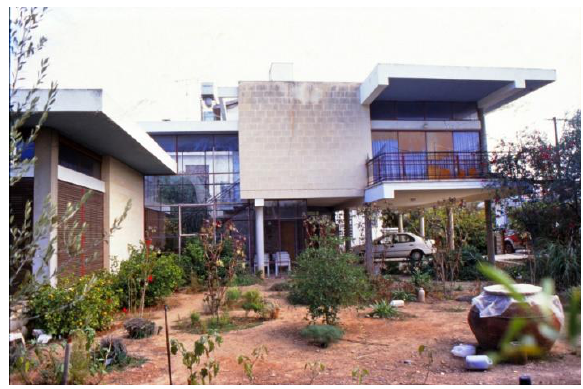
Figure 18. Theotodos Kanthos residence